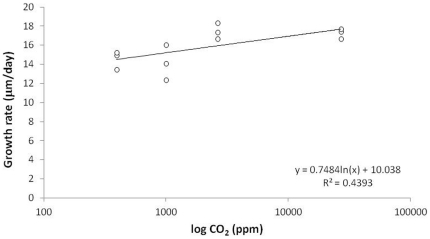
Impact of a range of pCO2 on the growth rate of newly hatched juveniles in presence of their photosymbiotic algae (9 days exposure; Experiment 3).A significant logarithmic relationships was observed between pCO2 and juvenile growth rate (F = 7.84, p<0.019), the growth rate being 19% faster in the highest test pCO2 (27 k µatm) compared to the lowest (0.4 k µatm).